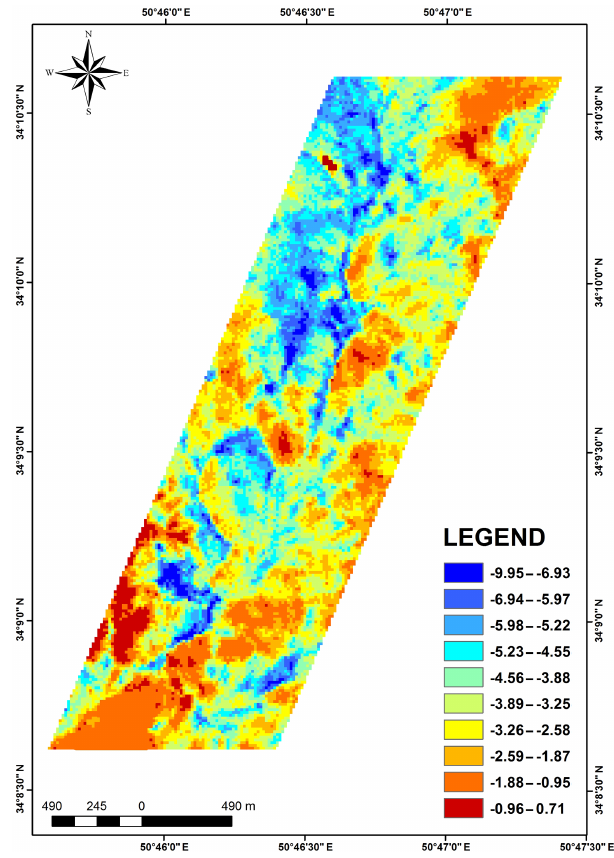
Figure 4. Mineral prospectivity map of the Sarvian area.